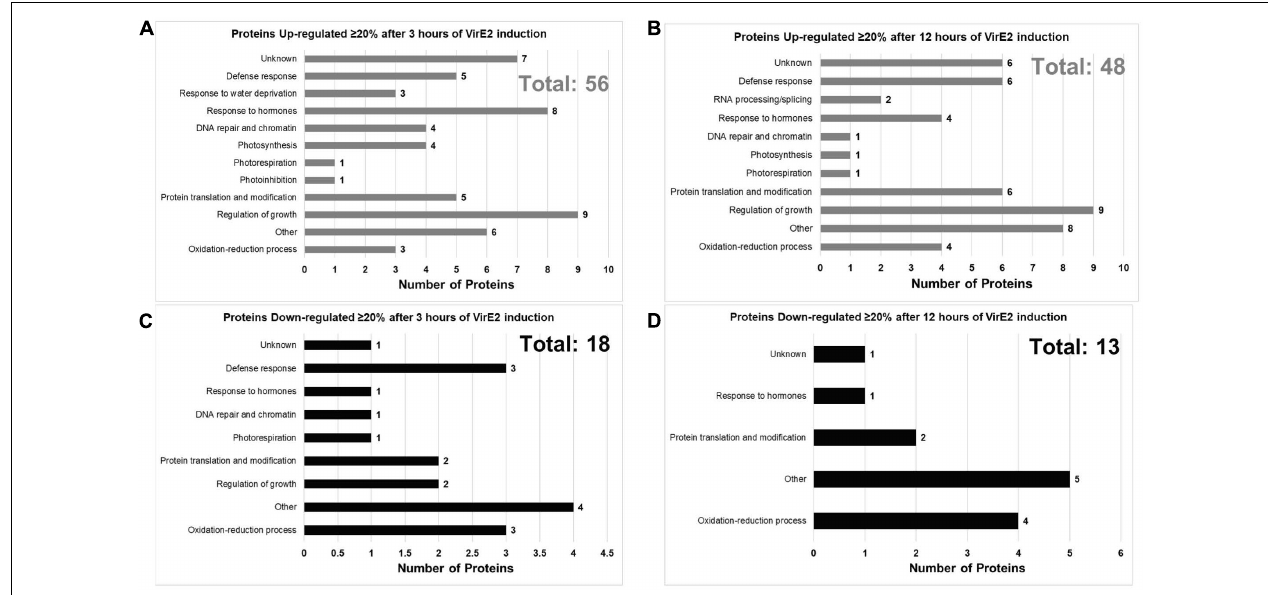
FIGURE 6 | Gene Ontology (GO) Biological Process Categories of VirE2 differentially expressed proteins. Proteins are grouped according to Gene Ontology (GO) process terms. Up-regulated proteins after 3 (A) or 12 (B) hours of VirE2 induction are shown along with down-regulated proteins after 3 (C) or 12 (D) hours of VirE2 induction. Only proteins which showed at least a 20% change in abundance for all three biological replicates determined by two different computational methods are shown. Total protein number is shown in the upper right corner of each graph and is highlighted in gray (up-regulated) or in black